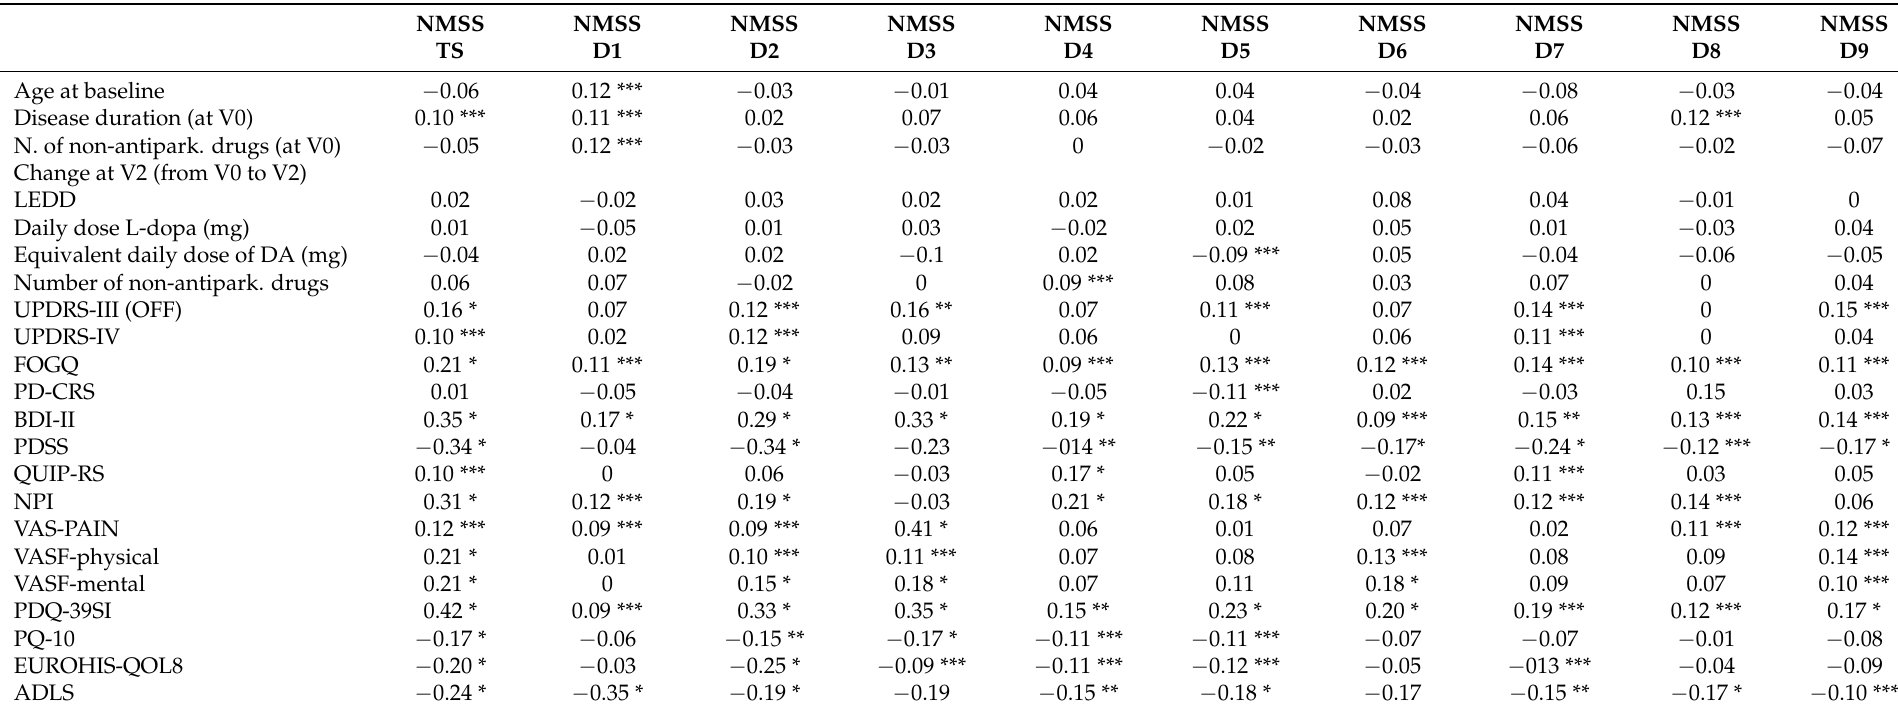
Table 2. Correlations between the changes in non-motor symptoms (NMSS total score and NMSS domains) and other disease-related variables in PD patients from V0 (baseline) to V2 (2 years ± 1